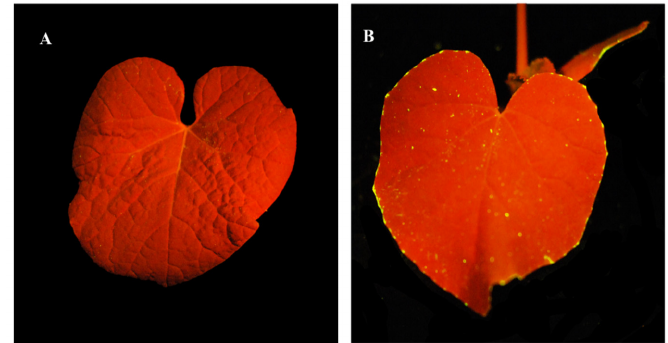
Figure 3. Fluorescence images of translocation to the leaves of bacteriophages added to soil. ( A ) Melon plant without phage addition. ( B ) Melon plant 24 h after addition of DAPI-stained phage ACPWH to soil.